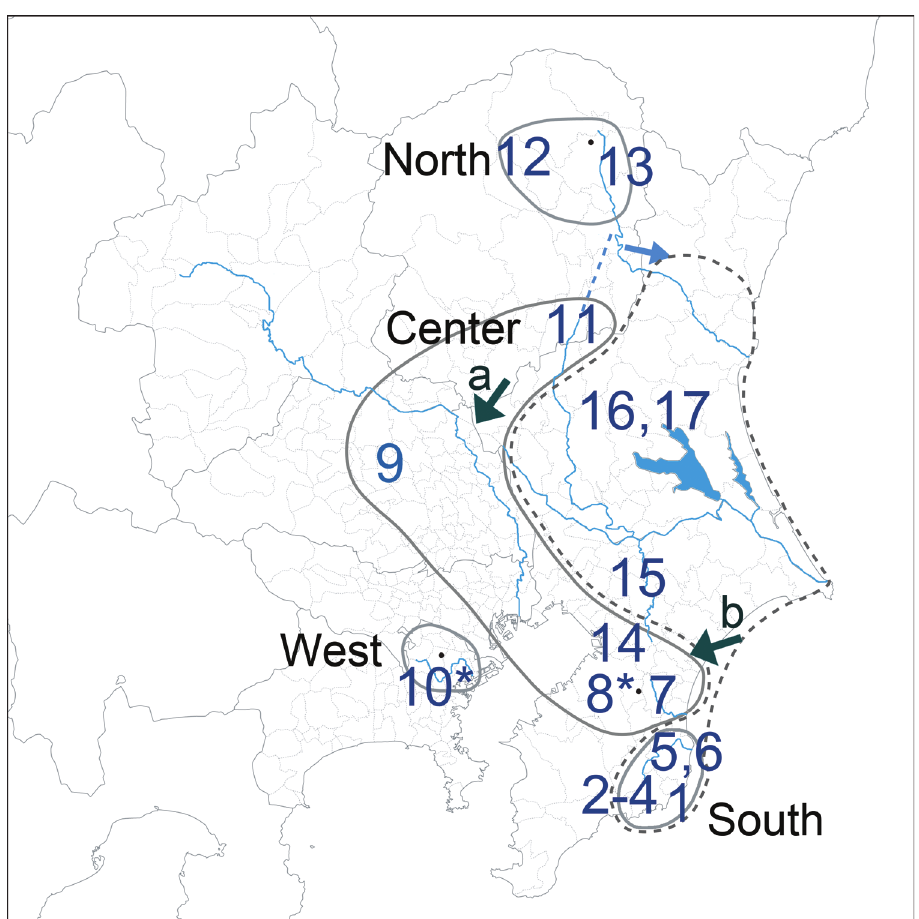
Figure 3. Geographic grouping of localities (encircled by gray solid lines) and river connectivity in 16th century (blue solid lines). Gray broken line encircles localities with the South geographic group including newly found localities (#15–17). Another newly found locality (#14) could be a member of the Center geographic group, but its haplotype composition is not typical among localities of the group. Arrows a and b denote historical overflow or stream capture terrains between river basins. Blue broken line indicates ancient river flow, and a blue arrow denotes change of the river flow at 500